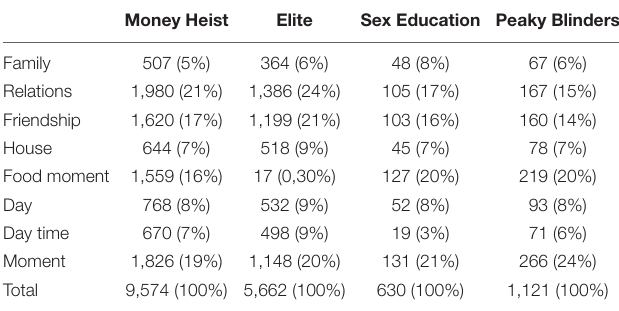
TABLE 7 | Frequencies and percentages of mentions regarding close context.